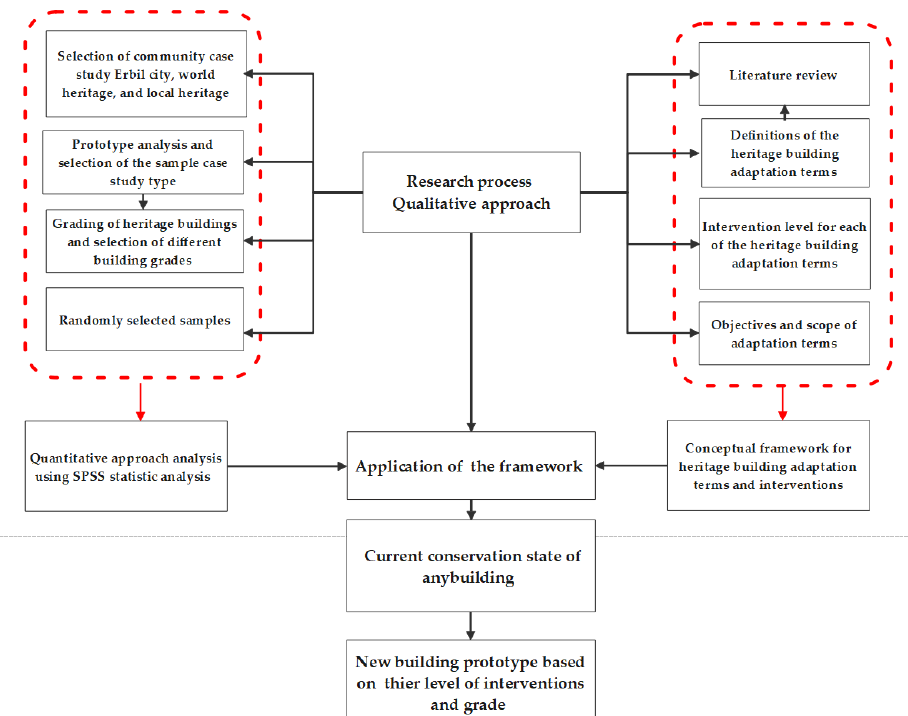
Figure 1. Workflow procedure of the study.